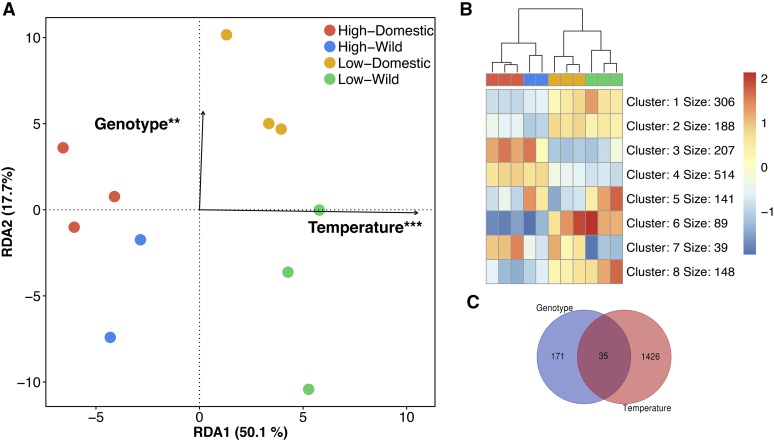
Effect of temperature and genotype one gene expression. A) Distance-base redundancy analysis (db-RDA) performed on the expression data (logCPM [prior count 2)]. Only genes with min logCPM > 1 in at least three samples were retained for the analysis (n = 14,372). The db-RDA model was globally significant (P < 0.001) and explained 59.8% of all expression variation (adj. R2 = 0.598). Genotype and temperature significantly explained 17.7% and 50.1% of the variation, respectively, after controlling for each other with subsequent partial db-RDAs. Significance codes: p-value < 0.001 ‘***’; p-value < 0.01 ‘**’; B) Heatmap and K-means clustering of genes showing differential expression between genotypes and/or temperature; C) Venn diagram showing the overlap between genotype and temperature in an additive effect (parallel reaction norms).